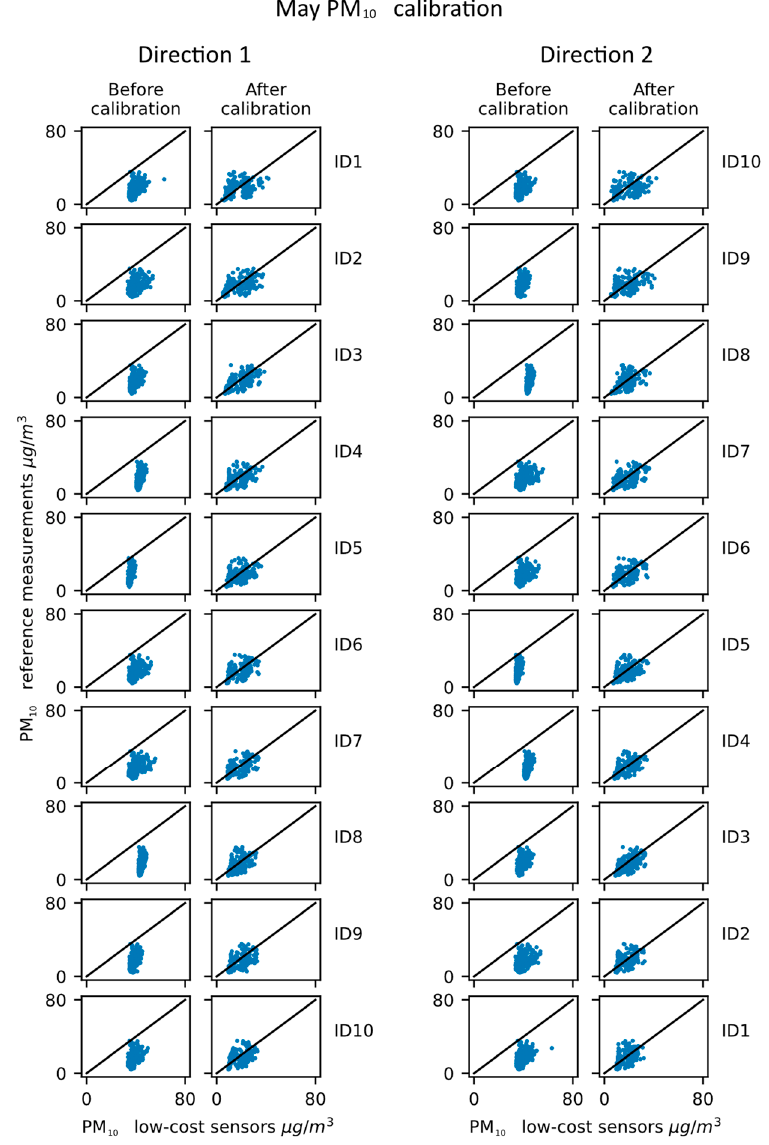
Figure 8. PM 10 calibration propagation—May results.